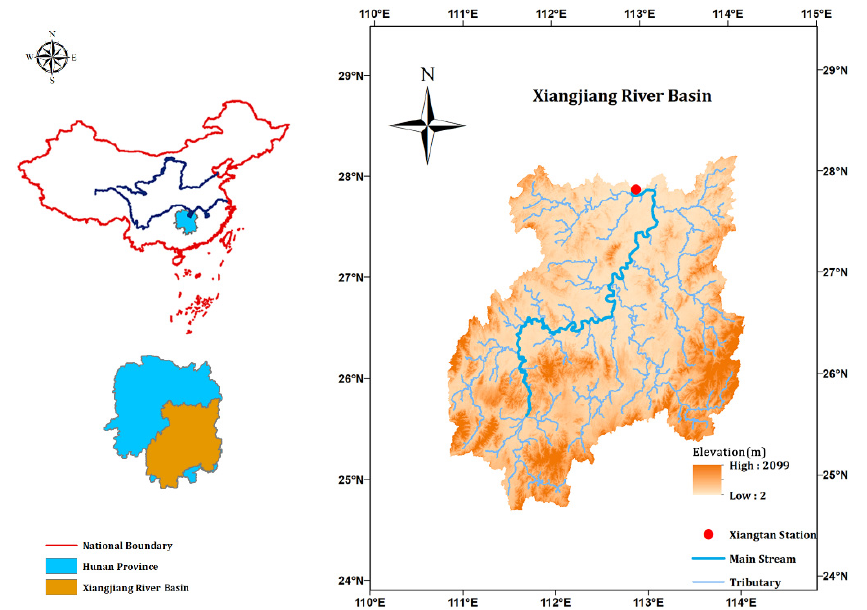
Figure 1. The location of Xiangjiang River basin and Xiangtan hydrological station.